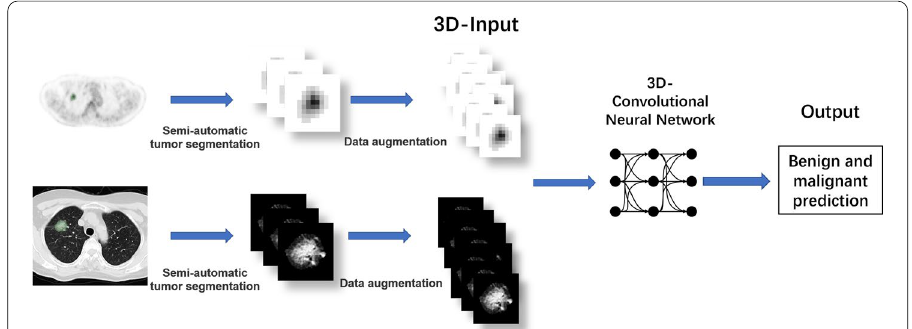
Fig. 2 The overview of the process of generating deep learning algorithms to predict benign and malignant